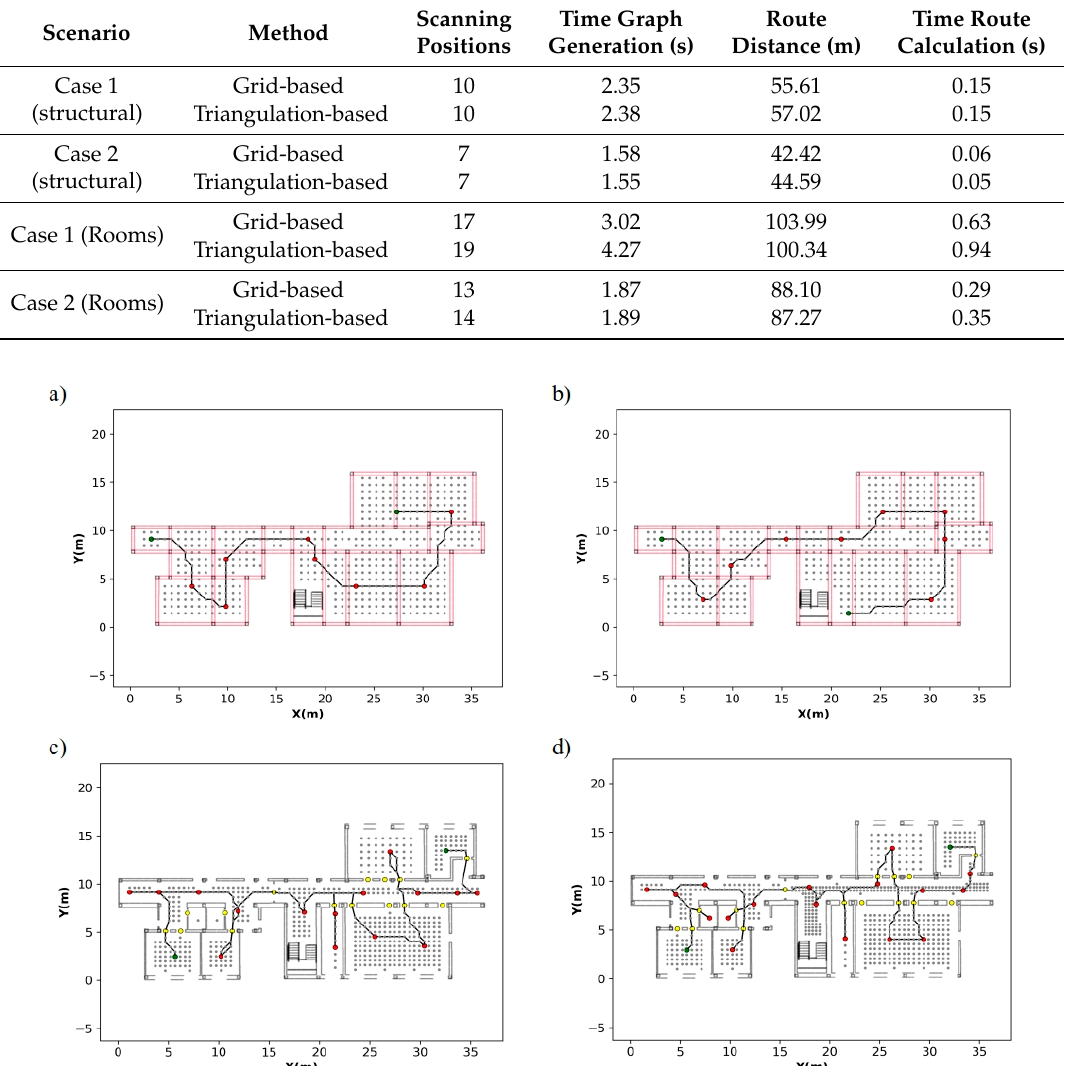
Table 7. Results optimal route calculation.